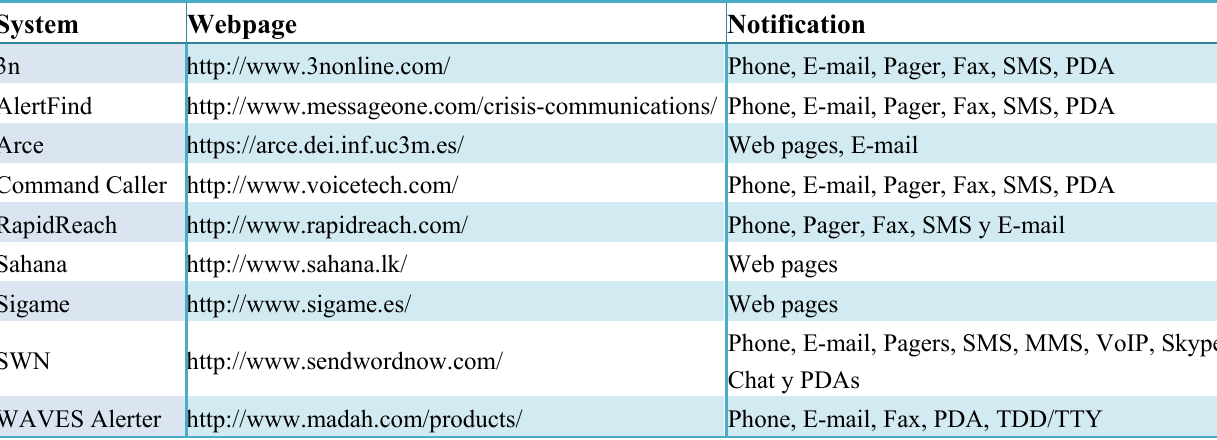
Table 1. List of alert notification systems (Adapted from